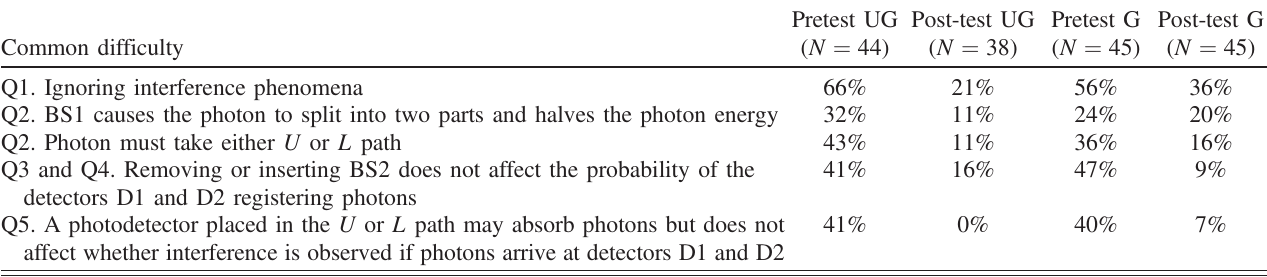
TABLE I. Common difficulties and percentages of undergraduate students (UG) and graduate students (G) displaying them on the MZI pretest or post-test questions involving single photons. The number of students who took the pretest does not match the post-test because some students did not work through the QuILT completely and their answers on the post-test were disregarded.